Question: Condense the content of this figure into a single sentence.
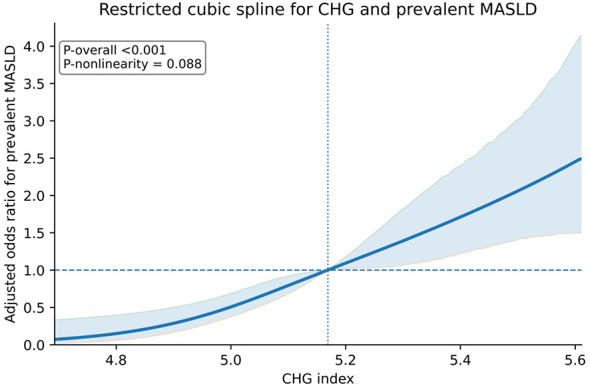
Answer: R estricted cubic spline depicting the association between CHG and prevalent MASLD in Model 3. The display is restricted to the 5th-95th percentile range of CHG to reduce sparse-tail instability of the confidence band.